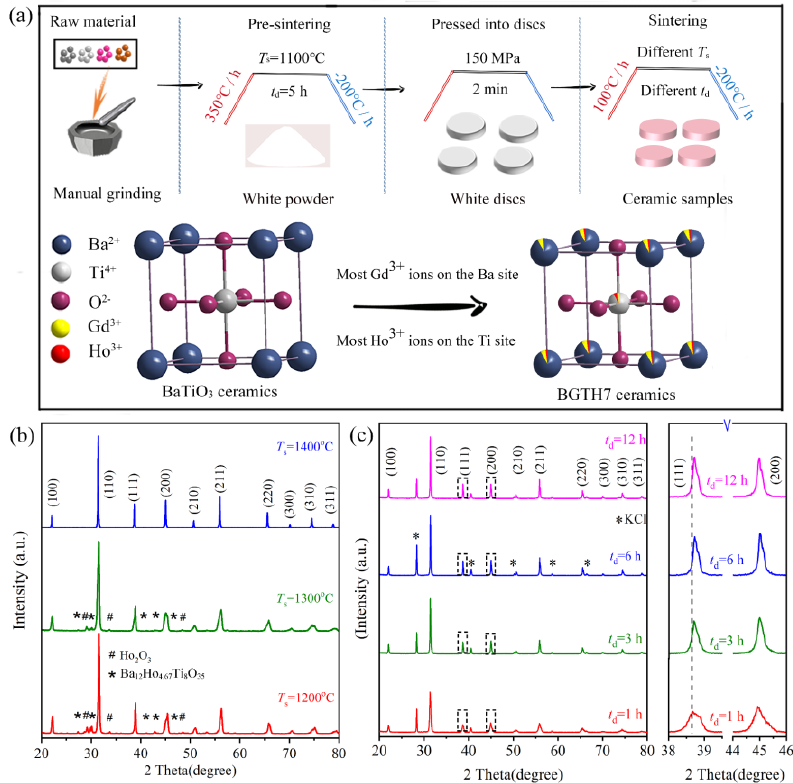
Figure 2. ( a ) Schematic illustration of the synthesis of BGTH7 ceramic samples. ( b ) X-ray diffraction patterns of the BGTH7 ceramics sintered at different sintering temperatures ( T s ) for 12 h. ( c ) X-ray diffraction patterns of BGTH7 ceramics sintered for different dwell times ( t d ) at 1400 °C. The right panel shows the enlarged diffraction peaks of (111) and (200) in the 2 θ ranges of 38 – 39.5° and 44 − 46°, respectively.